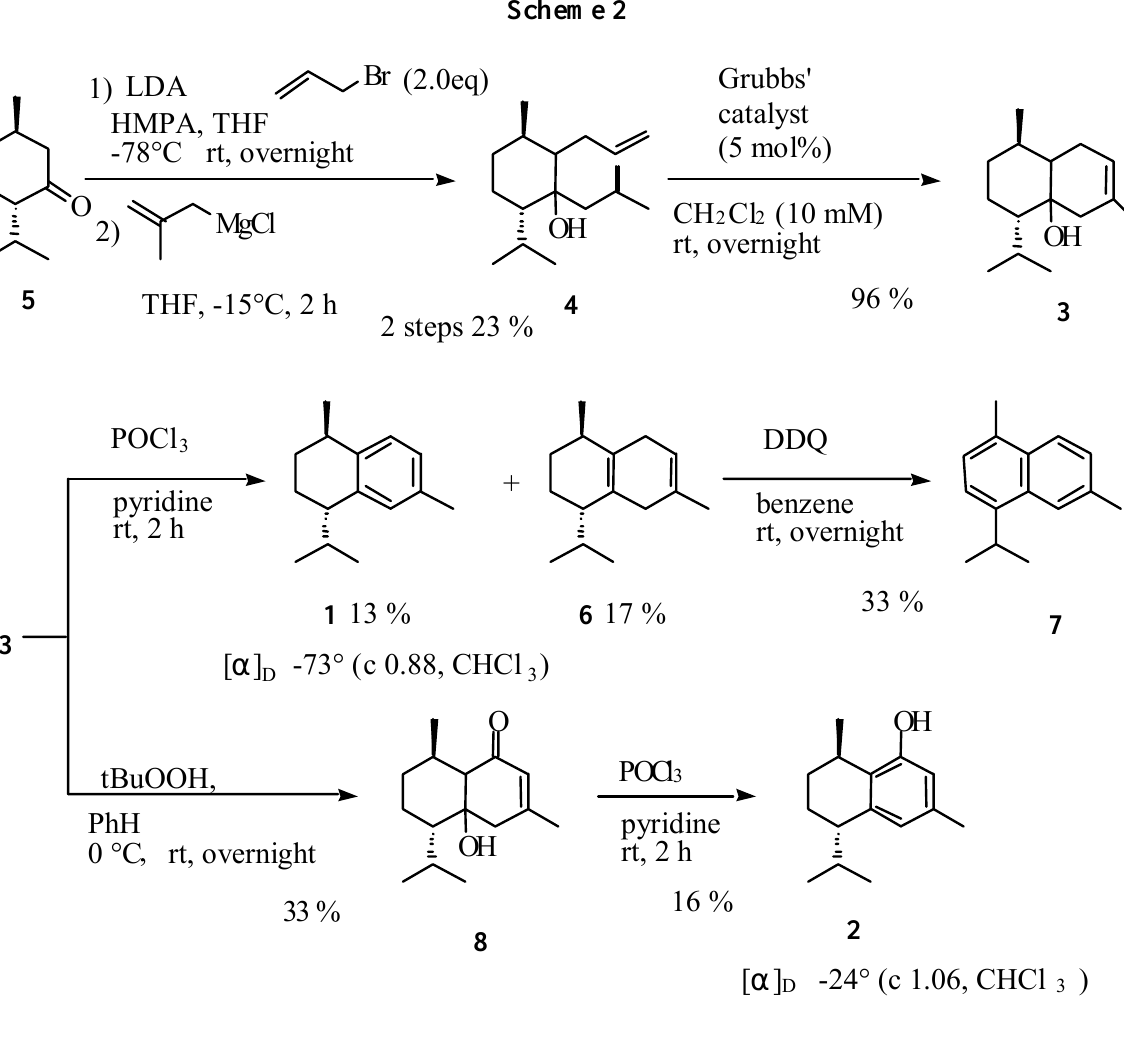
Figure 1. 1 H-NMR spectra of compound 1